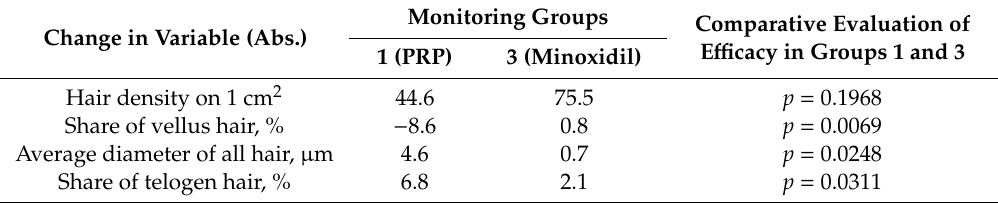
Table 2. Comparison of the effectiveness of treatment in observation groups 1 and 3. Change in Variable (Abs.)